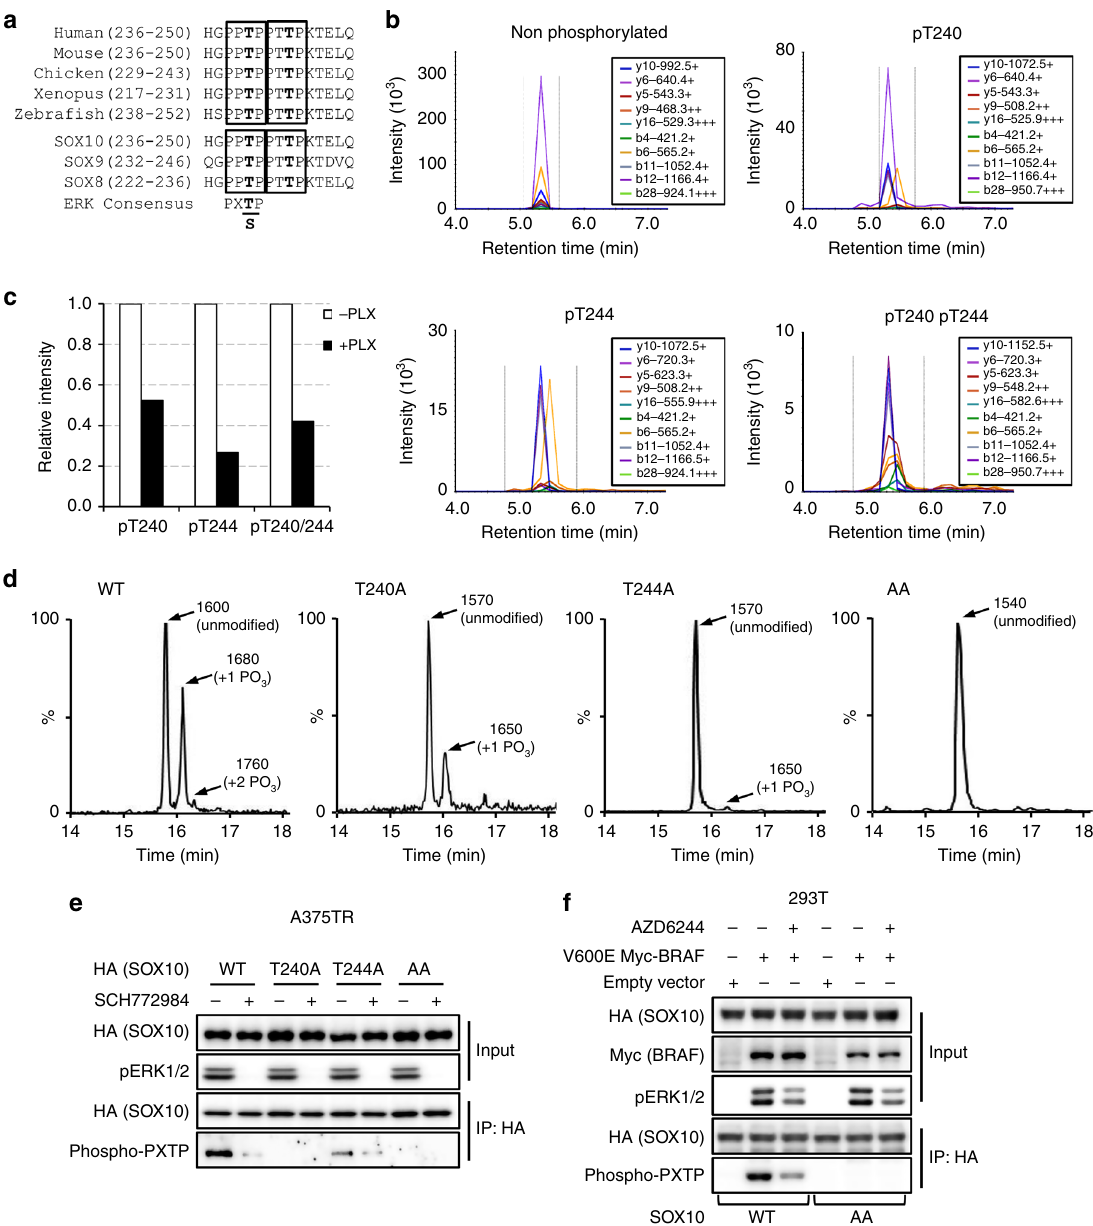
Fig. 3 ERK2 directly phosphorylates SOX10 at T240 and T244. a Sequence alignment of the putative ERK phosphorylation motifs in SOX10 from different species (top) and among SOXE family proteins (bottom). The putative phosphorylation motifs were highlighted in box and phosphorylation sites (T) are shown in bold. The consensus ERK phosphorylation motif is shown below the sequences. b In vivo detection of SOX10 phosphorylation at T240 and T244. HA-SOX10 proteins were immunoprecipitated from A375-TR HA-SOX10 cell lysates, digested by trypsin and analyzed by multiple reactions monitoring (MRM) mass spectrometry. MRM spectra of non-phosphorylated and T240/T244-phosphorylated SOX10 tryptic fragments are shown. c Quantitation of SOX10 phosphorylation in A375 cells treated with or without 2 μ M Vemurafenib for 6 h. The areas of the peptide peaks in MRM chromatograms were measured to estimate the relative quantities of corresponding peptides. A SOX10 tryptic fragment (183 AAQGEAECPGGEAEQGGTAAIQAHYK 208, 848.7188+++) was used as the internal control. d In vitro kinase assays were performed using recombinant ERK2 (activated) and synthetic SOX10 peptides (236-HGPPTPPTTPKTELQ-250) and the reaction products were analyzed by LC – MS. The HPLC results for SOX10 peptide variants including WT, T240A, T244A, and AA are shown. Different peptide species detected in the reaction products were designated by arrows with their molecular weights and identities shown beside. Mass spectrometry results were included in the supplemental information (Supplementary Fig. 3). e WT, T240A, T244A, AA HA- SOX10 proteins were precipitated from lysates of lentivirus-transduced A375 cells treated with or without 1 μ M SCH772984 and probed with anti-HA or anti-phospho-PXTP antibodies. Uncropped images are shown in Supplementary Fig. 10. f 293T cells were transduced with WT or AA HA-SOX10 constructs along with empty vector or V600E BRAF constructs, ± AZD6244 treatment. Cells were lysed and HA-SOX10 were immunoprecipiated and probed with indicated antibodies. Uncropped images are shown in Supplementary Fig.